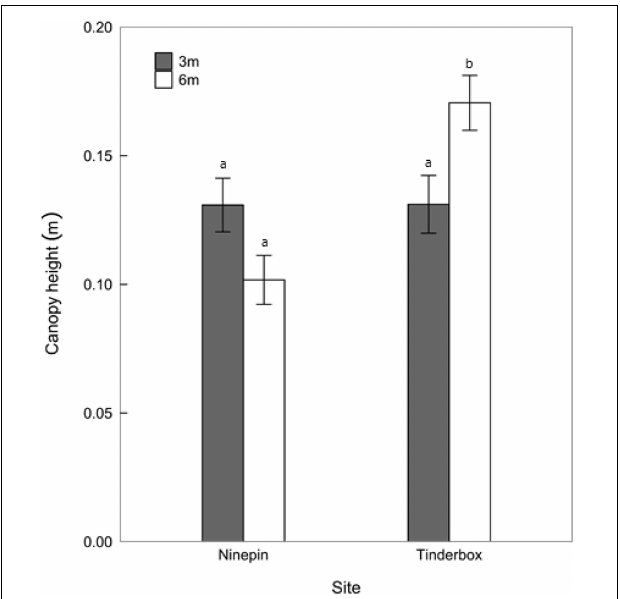
FIGURE 4 | Canopy heights at Ninepin Point and Tinderbox at two depths, 3 and 6 m. n = 20–24 ± SE. Letters denote significant difference of canopy height between sites and depth (LSD), P < 0.05.